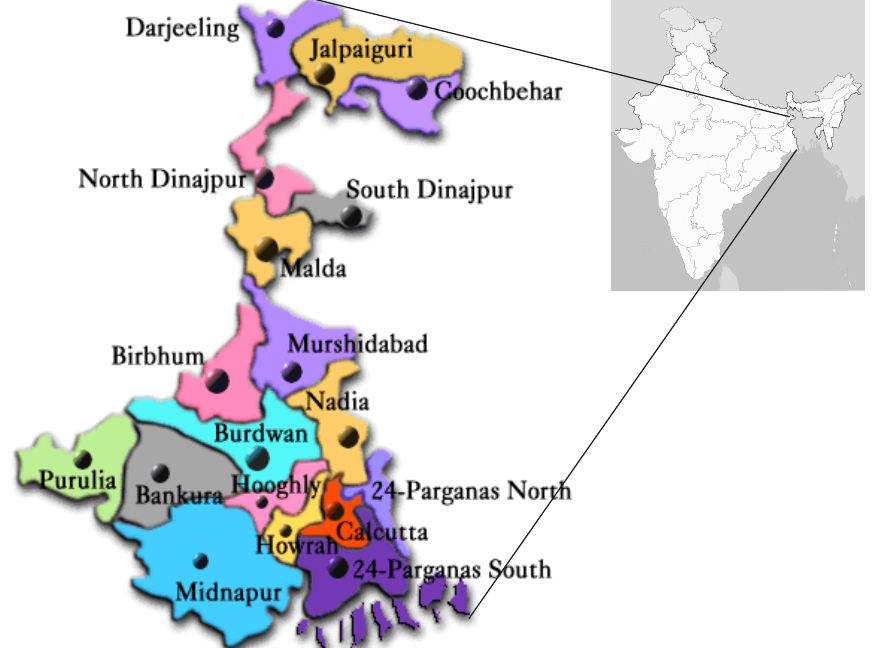
Image 1. Location map of the study area in northern West Bengal,